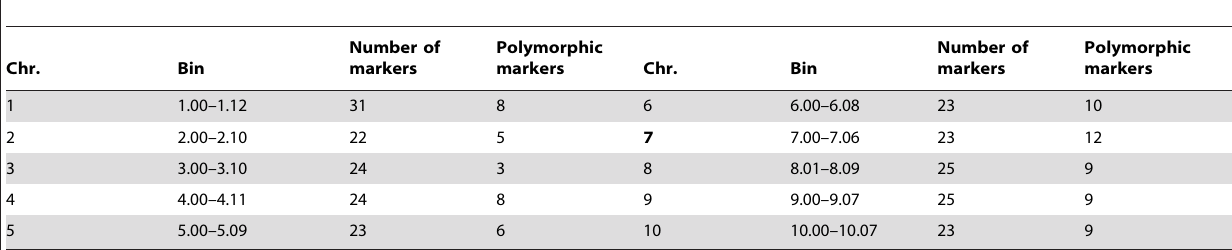
Table 1. Polymorphic SSR markers screened among QCL5019, Taixi19, and QCL3021 through whole genome in maize.